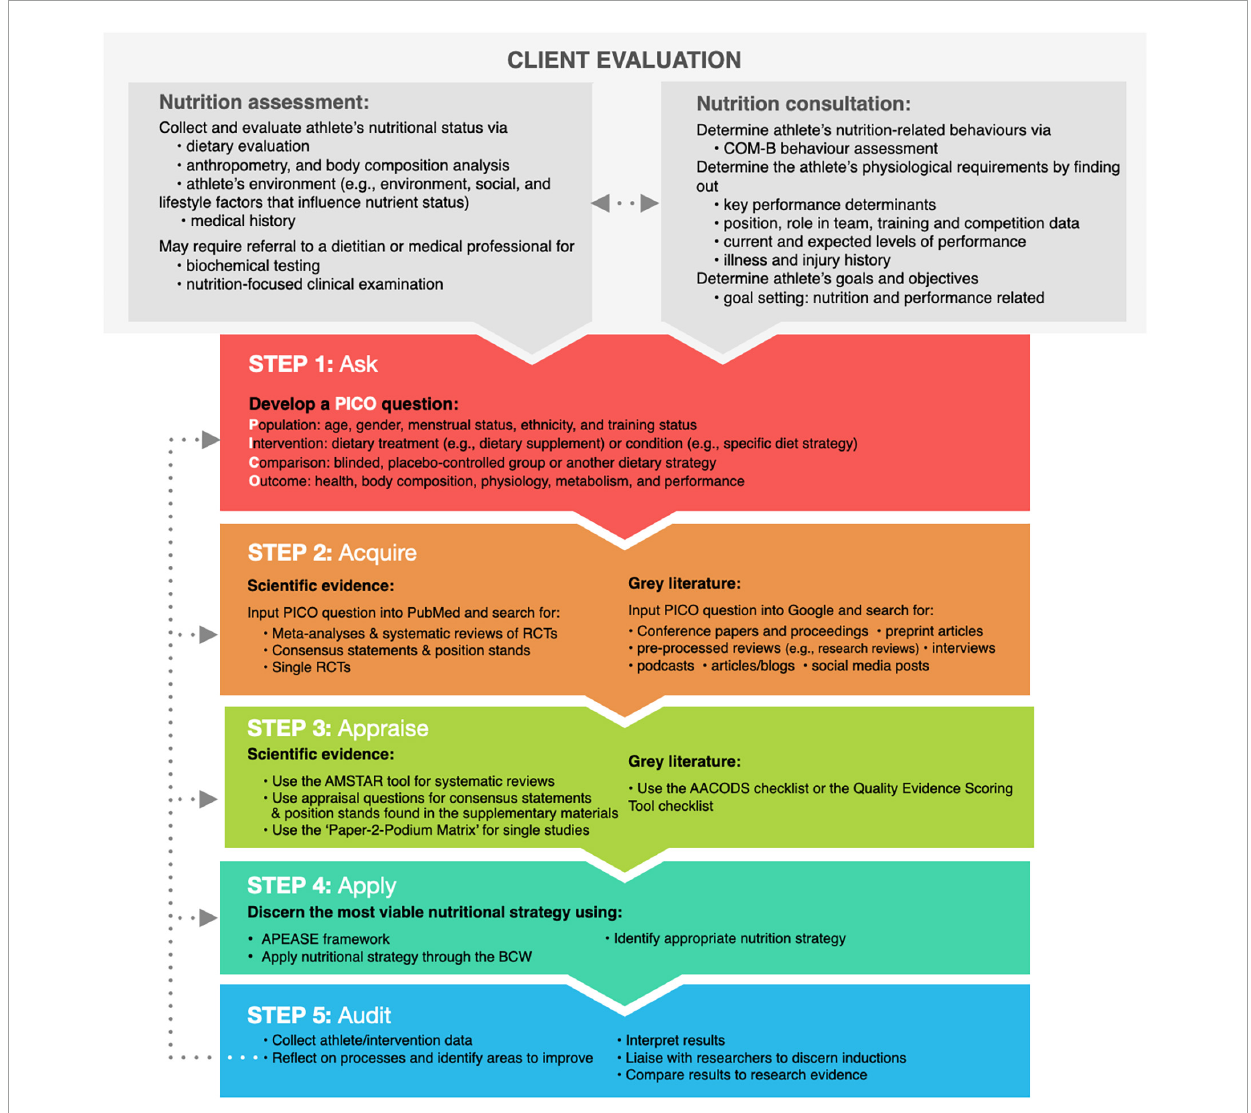
FIGURE1 An adapted overview of the five-step EBP framework for sports nutrition practitioners. The dotted lines illustrate self-auditing Steps 1–4 to identify opportunities for development using the EBP framework. BCW, behaviour change wheel; RCT, randomised controlled trial.